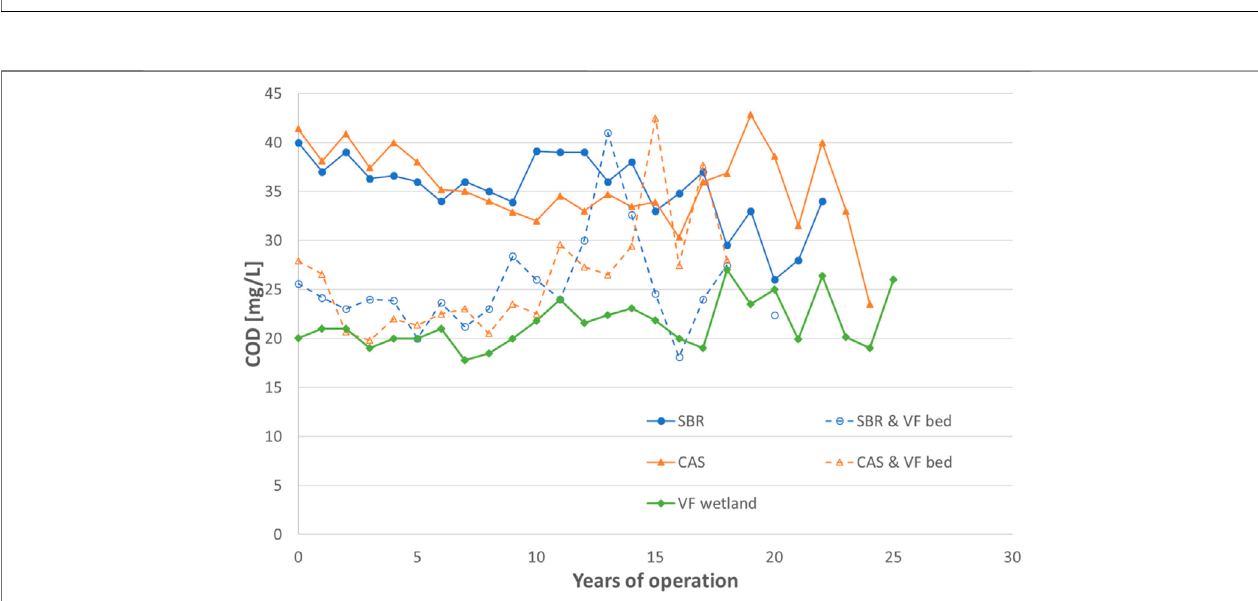
FIGURE 6 | Median values of the COD ef fl uent concentrations of technologies with or without VF beds and VF wetlands in relation to the age of the small WWTP.